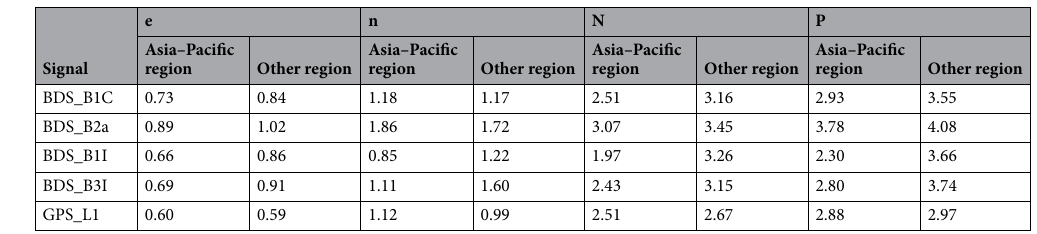
Table 6. Average of the positioning errors RMS over all observation stations for single-frequency SPP (unit: m).